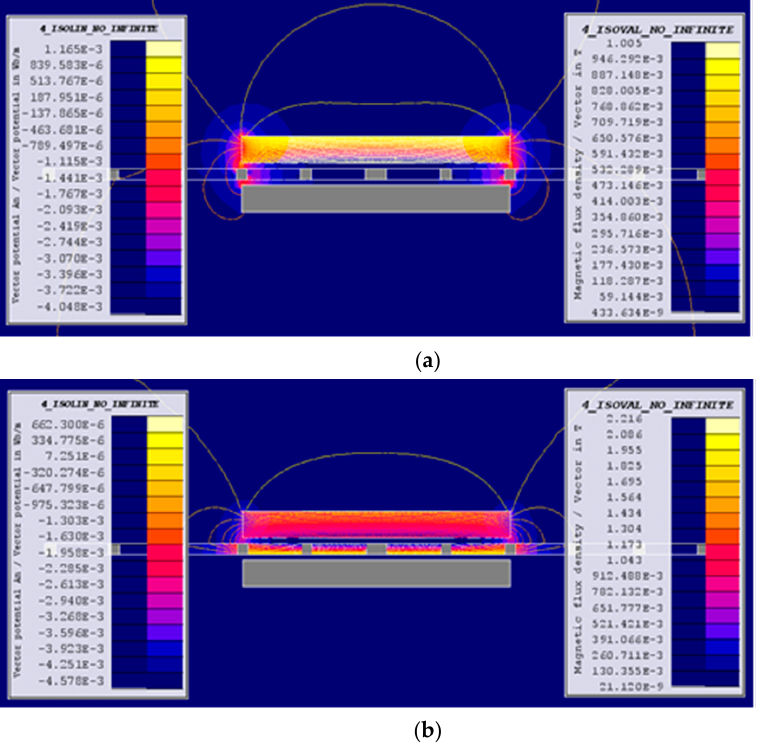
Figure 17. Density of magnetic field lines at DISTANCE_MP = 4 mm, THICKNESS_ROTOR = 2 mm, gadolinium (Gd) in the paramagnetic ( a ) and ferromagnetic ( b ) range. Increasing the thickness of the rotor also implies the proper spacing of permanent magnets. Gadolinium active elements in the paramagnetic and ferromagnetic field, re- spectively, under the influence of the magnetic field produced by the upper permanent magnet, can be analyzed in Figure 18 in terms of magnetic field density distribution.